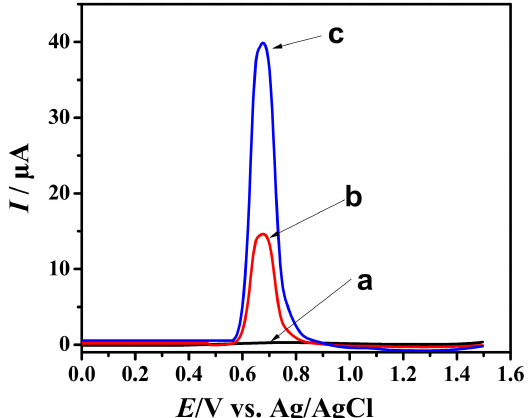
Figure 7. ( a ) Blank voltammogram obtained at Co–Pd@Al 2 O 3 /GCE is for the buffered medium (BRB solution of pH of 7), ( b ) voltammogram of the 2 µ M solution of VEN in BRB of pH 7 at bare GCE, ( c ) voltammogram of the 2 µ M solution of VEN in BRB of pH 7 at Co–Pd@Al 2 O 3 /GCE. Conditions: scan rate of 50 mV/s; deposition potential of − 0.5 V; deposition time of 60